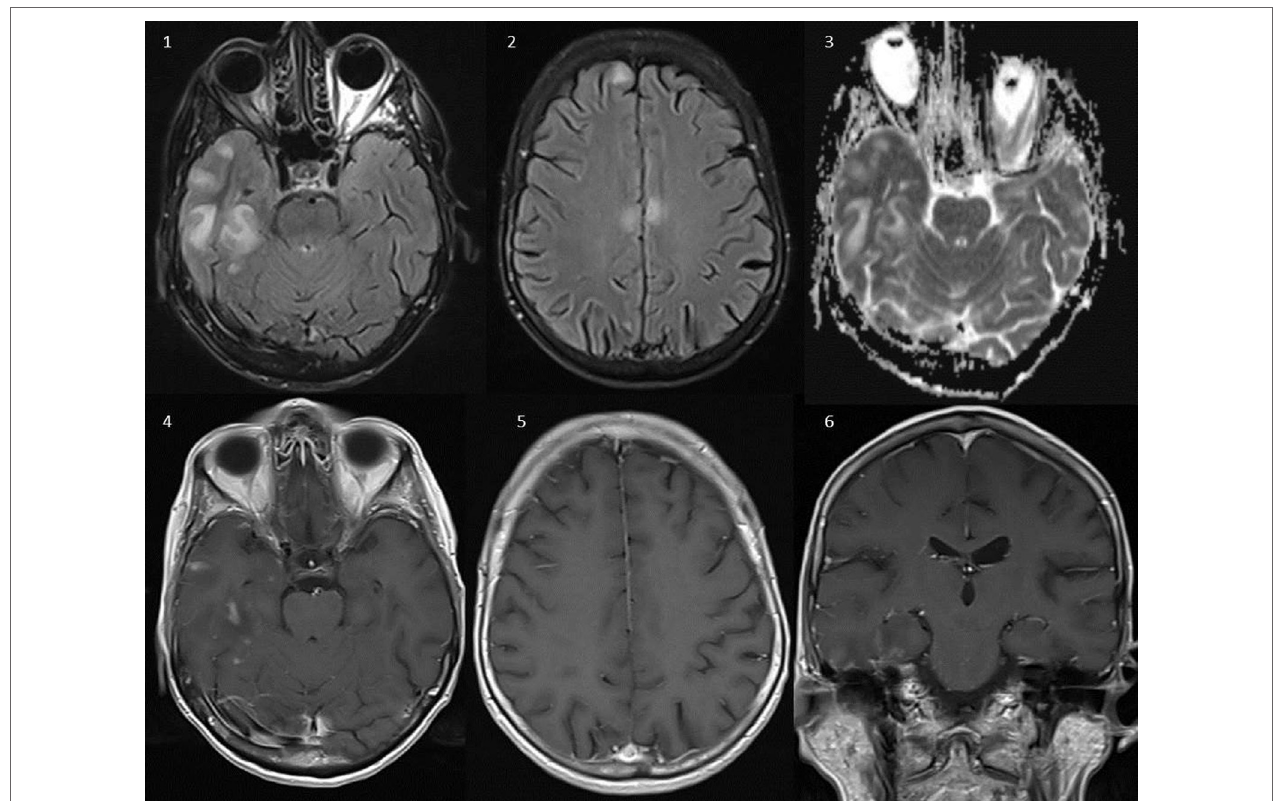
FIgURe 2 | Brain magnetic resonance imaging (Siemens Aera 1.5 T). Axial FLAIR (1, 2), axial ADC-maps (3), axial T1 after intravenous gadolinium (4, 5), and coronal T1 after intravenous gadolinium (6). Several lesions with high T2-signal on FLAIR in the right temporal lobe, bilateral in the frontal lobe, and the callosal body without signs of restricted diffusion on the ADC-maps, compatible with vasogenic edema. Several lesions in the right temporal lobe show patchy contrast enhancement after intravenous administration of gadolinium-based contrast (4–6). None of the lesions were